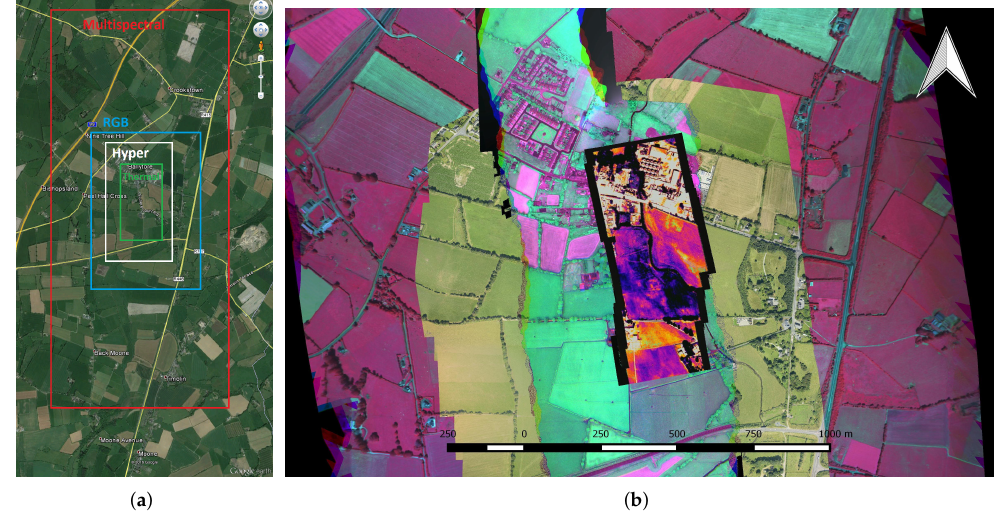
Figure 9. Sensor pod outputs. ( a ) Location map indicating extents of each corrected and stitched image; ( b ) image registration—thermal, hyperspectral cube and RGB orthmosaic overlaid on FCC created from multispectral sensors.